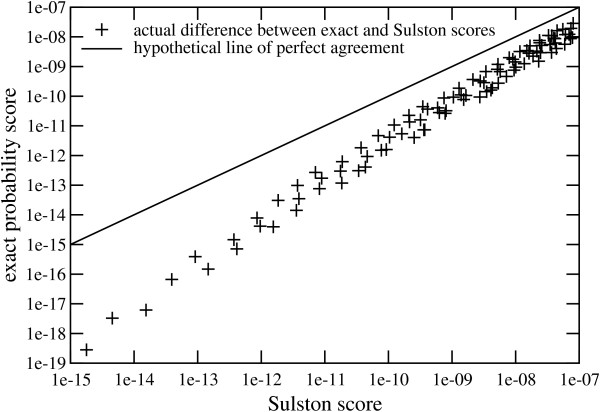
Sampling of exact probability versus Sulston score for t = 236.